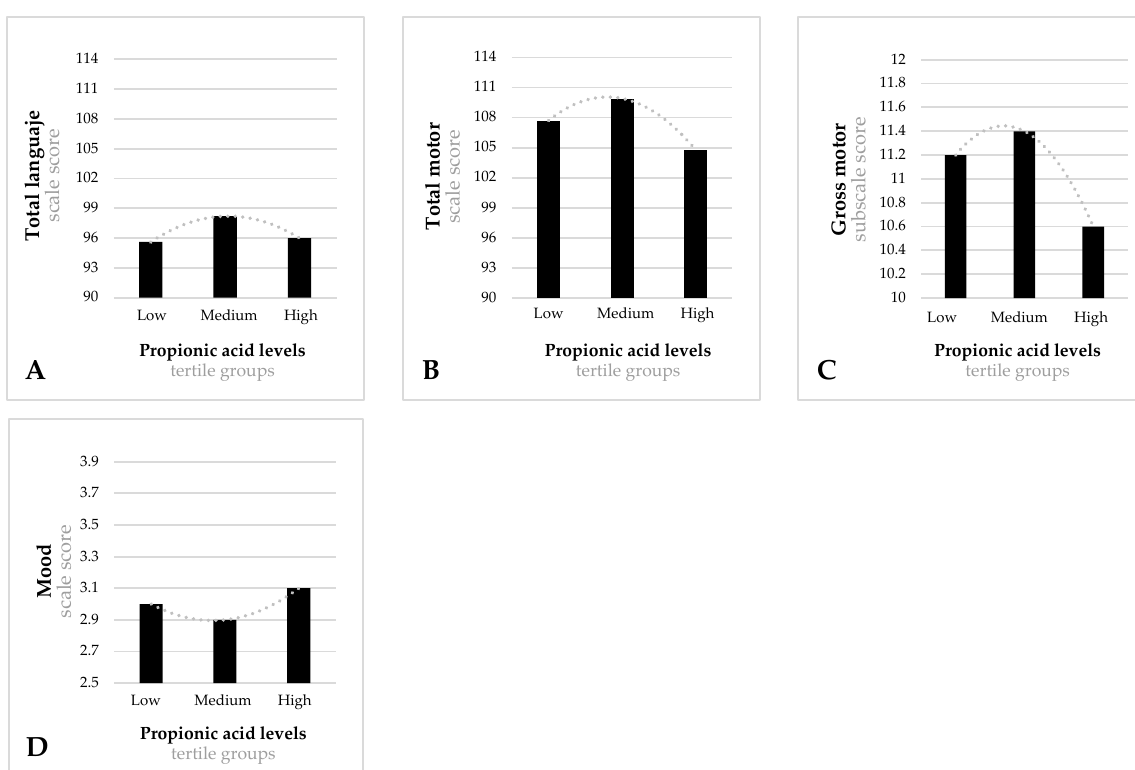
Figure 2. Total language ( A ) and motor scale ( B ), gross motor subscale ( C ), and mood temperament scale ( D ) scores for tertile groups of propionic acid at the first trimester. ( A ) Low-tertile mean score = 97.7 (SD = 8.2), medium-tertile mean score = 98.3 (SD = 8.4), high-tertile mean score = 95.8 (SD =